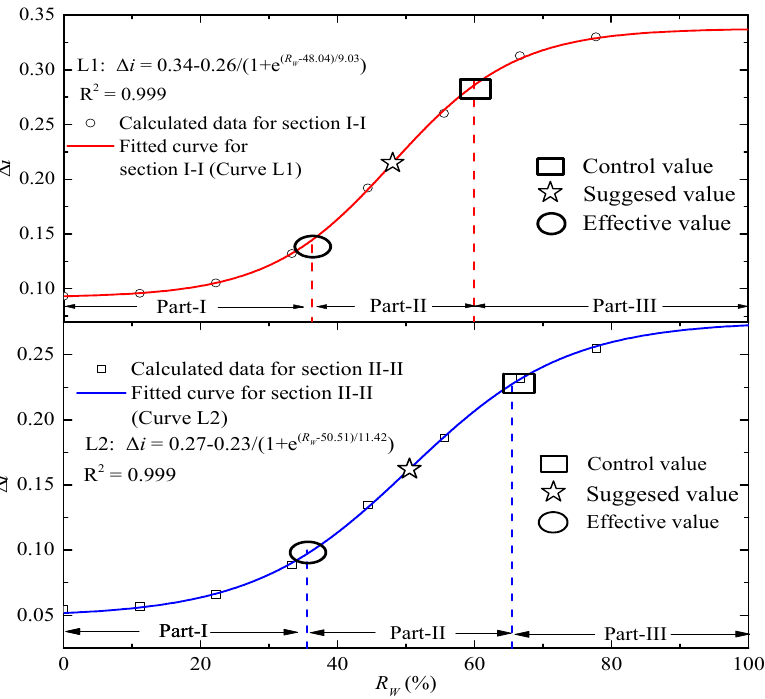
Figure 12. Relationship between Δ i and R W when R C is 10.